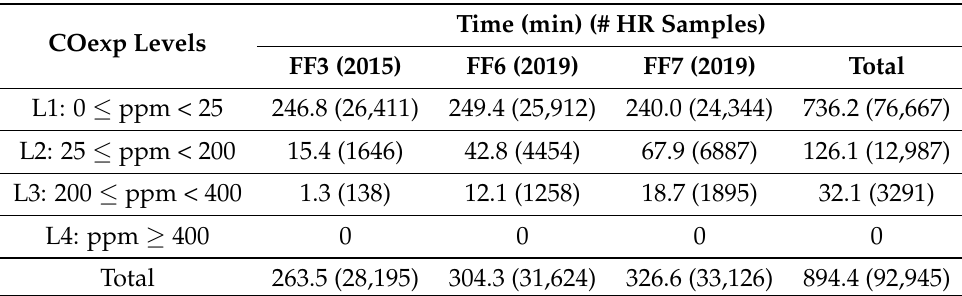
Table 1. Number of HR samples and exposure duration, per FF, as a function of CO exposure (COexp)